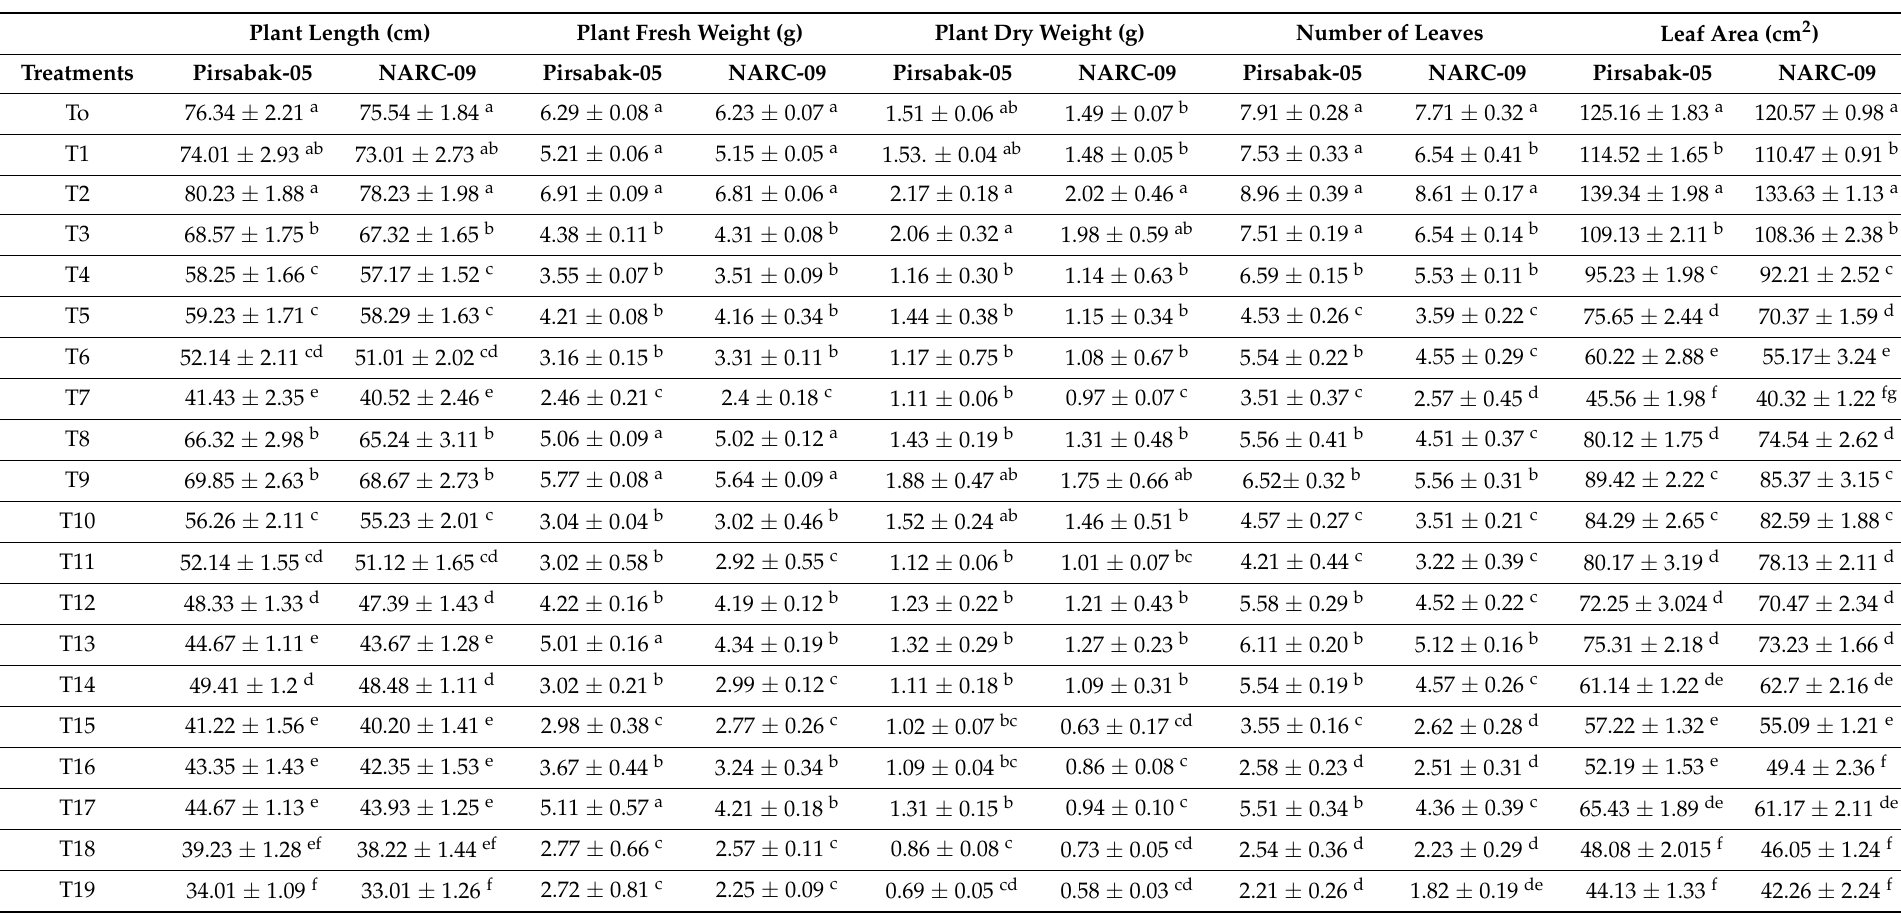
Table 3. Effects of foliar application of TiO 2 NPs (25, 50, 75, and 100 µ g/mL) on morphological parameters of wheat varieties (Pirsabak-05 and NARC-09) under different salt stresses (50, 100, and 150 mM NaCl)